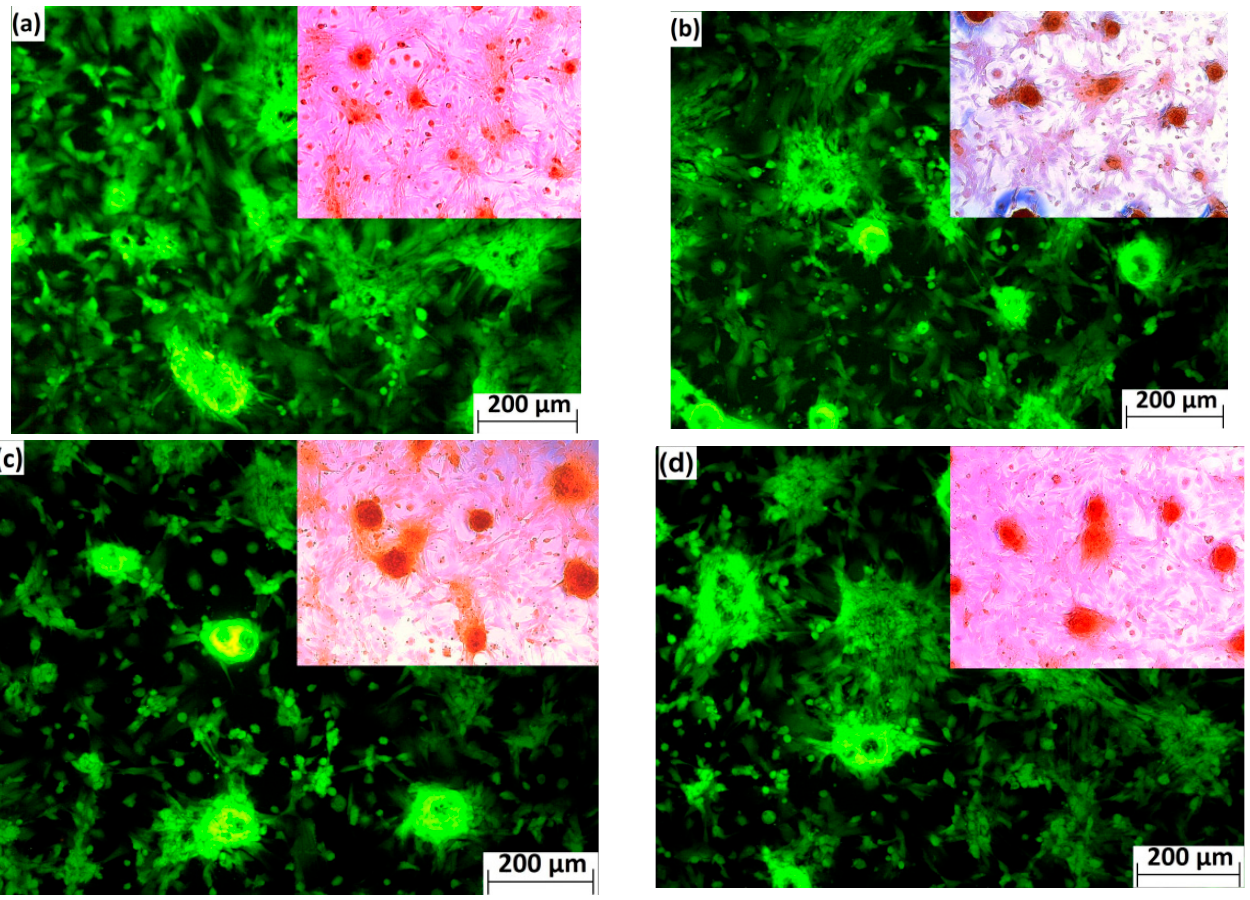
Figure 8. Morphology and distribution of MC3T3E1 osteoblasts cultured on CT ( a ), CT5MP ( b ), CT1Si ( c ), and CT5MP1Si ( d ) cement surfaces for 48 h (live/dead staining) and production of calcium deposits by differentiated rat MSCs cultured in 50% cement extracts for 14 days in details (Alizarin red staining).